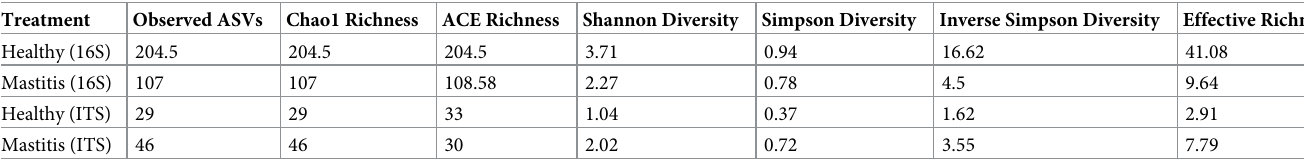
Table 7. Median alpha diversity measures by sample group for healthy and mastitis milk samples for 16S rRNA. Treatment Observed ASVs Chao1 Richness ACE Richness Shannon Diversity Simpson Diversity Inverse Simpson Diversity Effective Richness Healthy (16S)